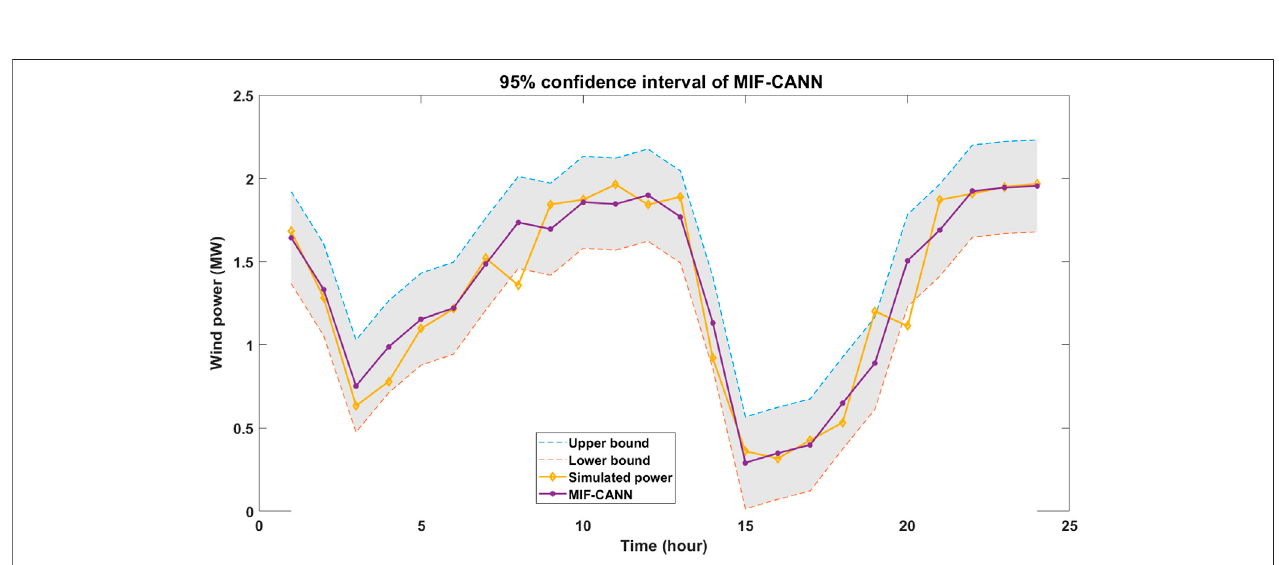
FIGURE 10 | 95% forecasting con fi dence interval of the proposed